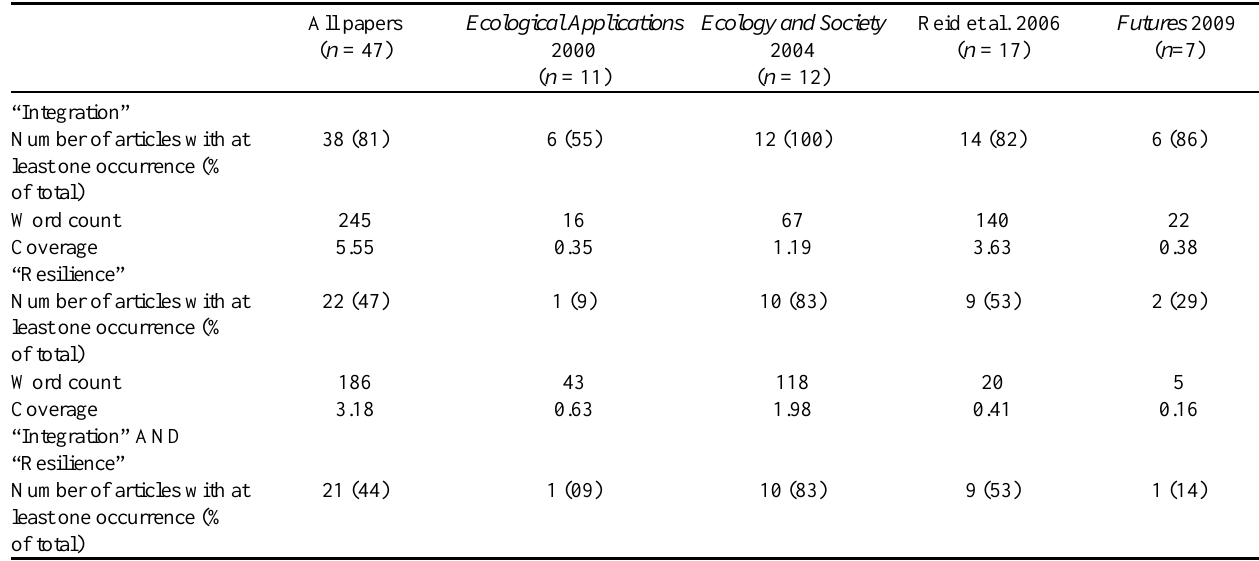
Table 3. Occurrences of “integration” and “resilience” in the reviewed literature. All papers Ecological ( n = 47)